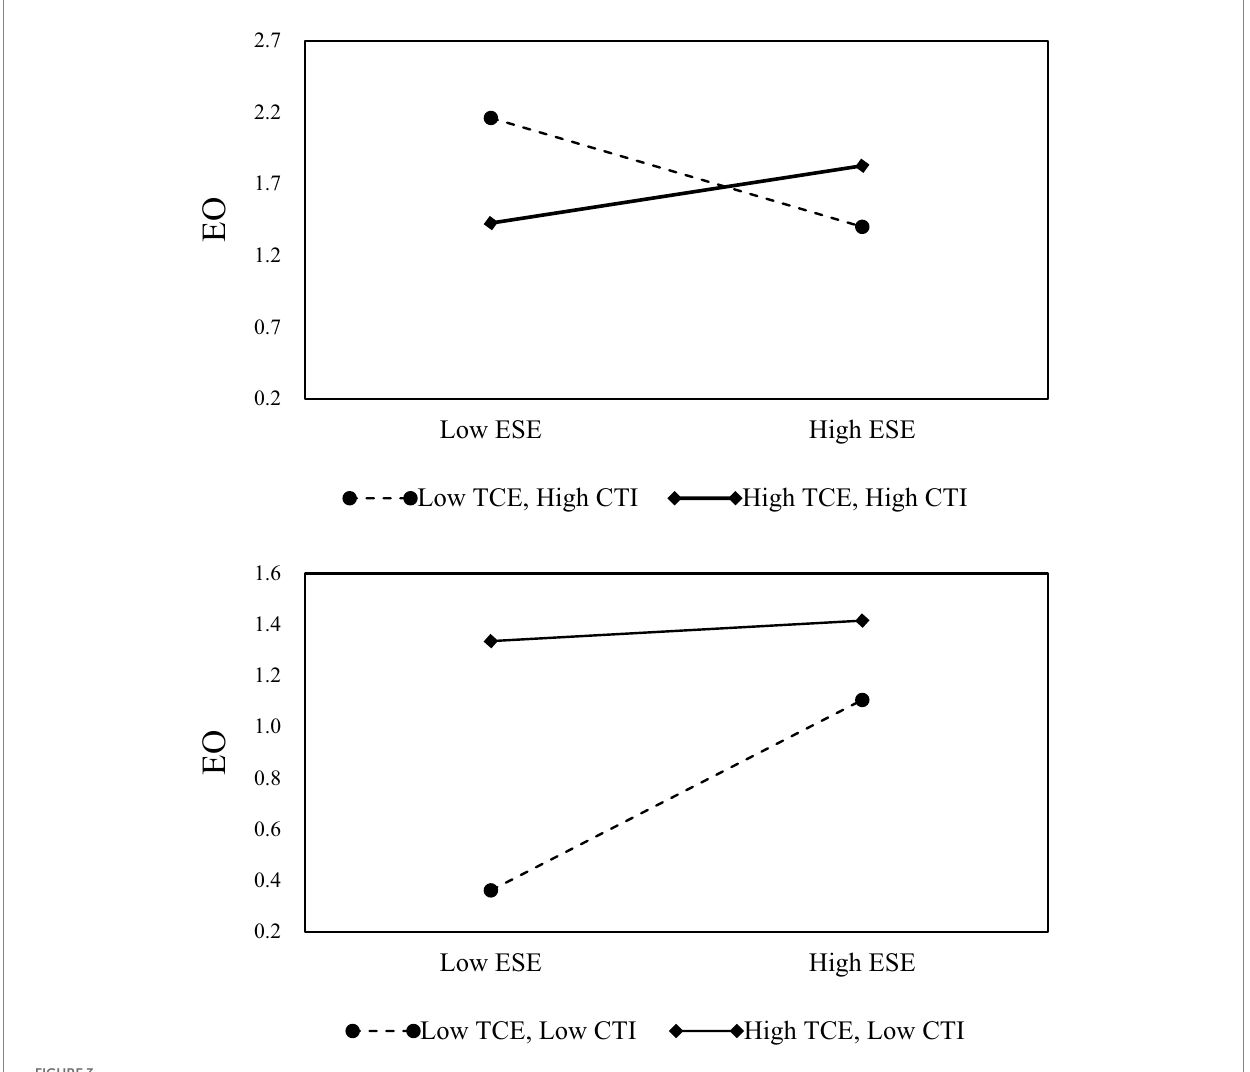
FIGURE 3 Interaction effect of CEO-TMT interface, entrepreneurial self-efficacy, and TMT collective efficacy on entrepreneurial